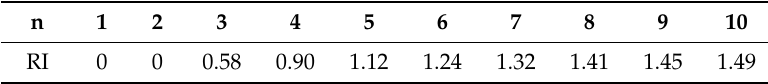
Table 4. Random Index based on number of